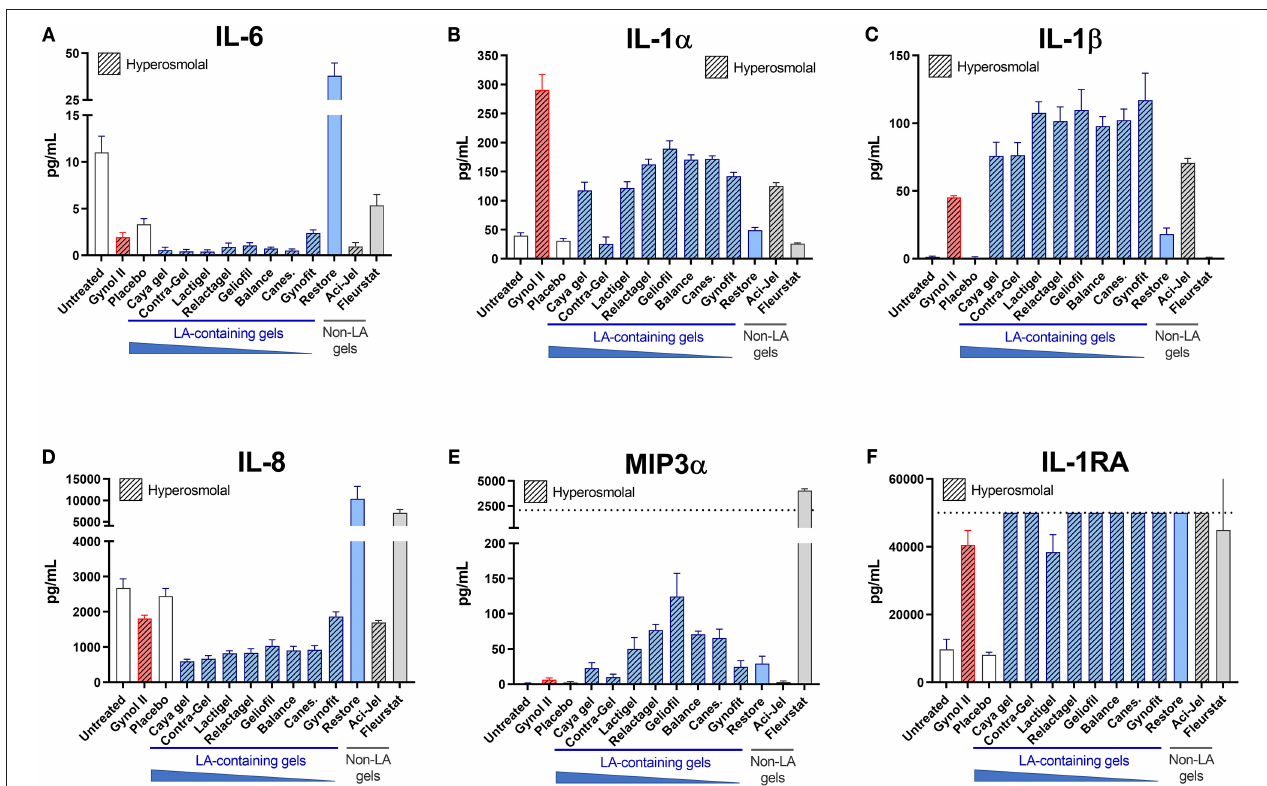
FIGURE 2 | Effects of LA-containing gels on inflammatory mediator production. The effect of over-the-counter (OTC) vaginal gels on the production of inflammatory factors from the EpiVaginal tissue model was assessed after 24h of treatment. Levels of IL-6 (A) , IL-1 α (B) , IL-1 β (C) , IL-8 (D) , MIP3 α (E) and IL-1RA (F) were measured in cell culture supernatants of treated tissues by Luminex assay. Hashed bars indicate hyperosmolal gels. Dotted lines indicate upper limit of quantitation (LOQ) of the assays in panels E and F, respectively; all other analytes were within the assay range. Graphs show mean and SEM of n = 6 replicates from two independent assays.